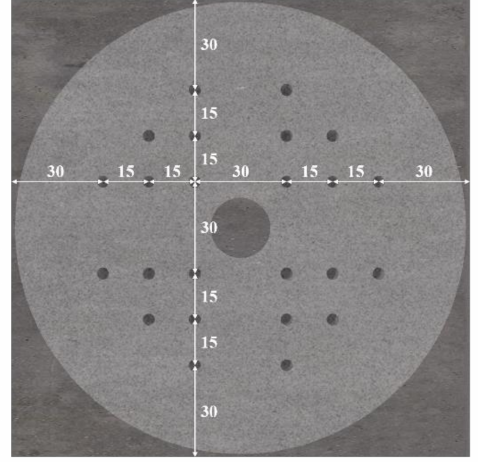
Figure 3. Schematic diagram of the pore